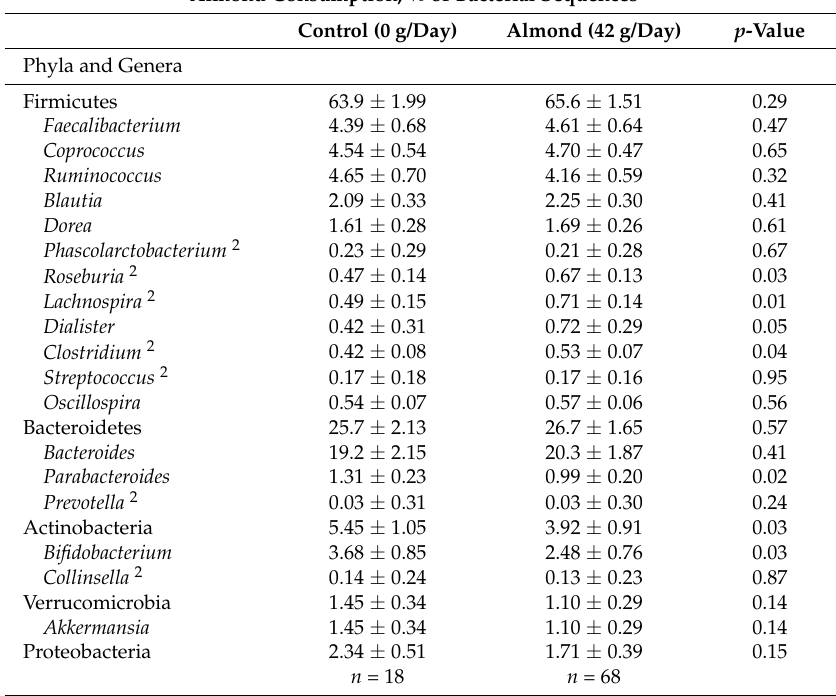
Table 2. Bacterial phyla and genera of human participants at the end of the control condition as compared to the end of the almond diet